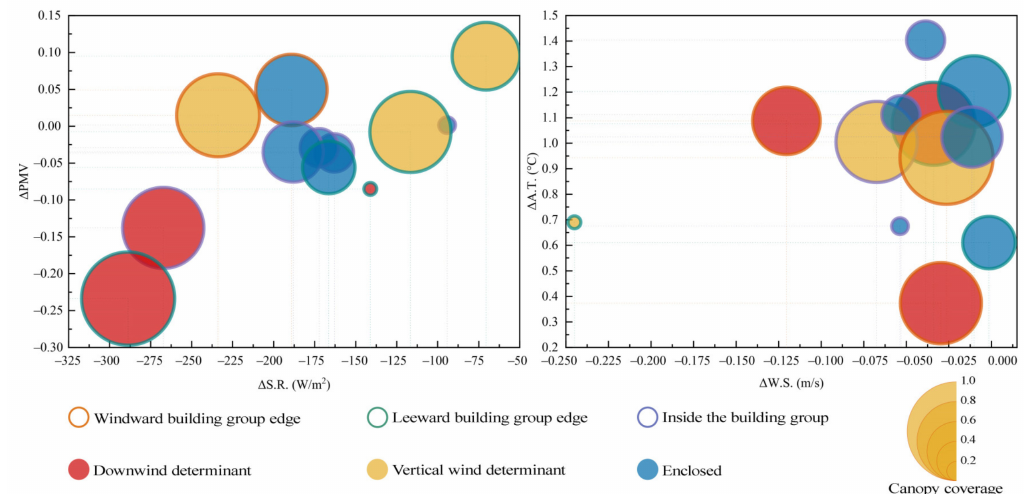
Figure 14. Bubble diagrams of 12 marquees on 15 March ( left ) and 15 December ( right